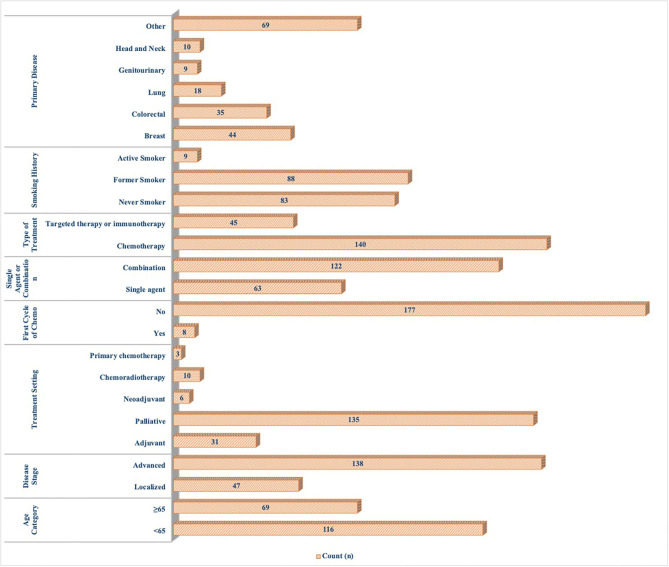
Baseline characteristics of patients.